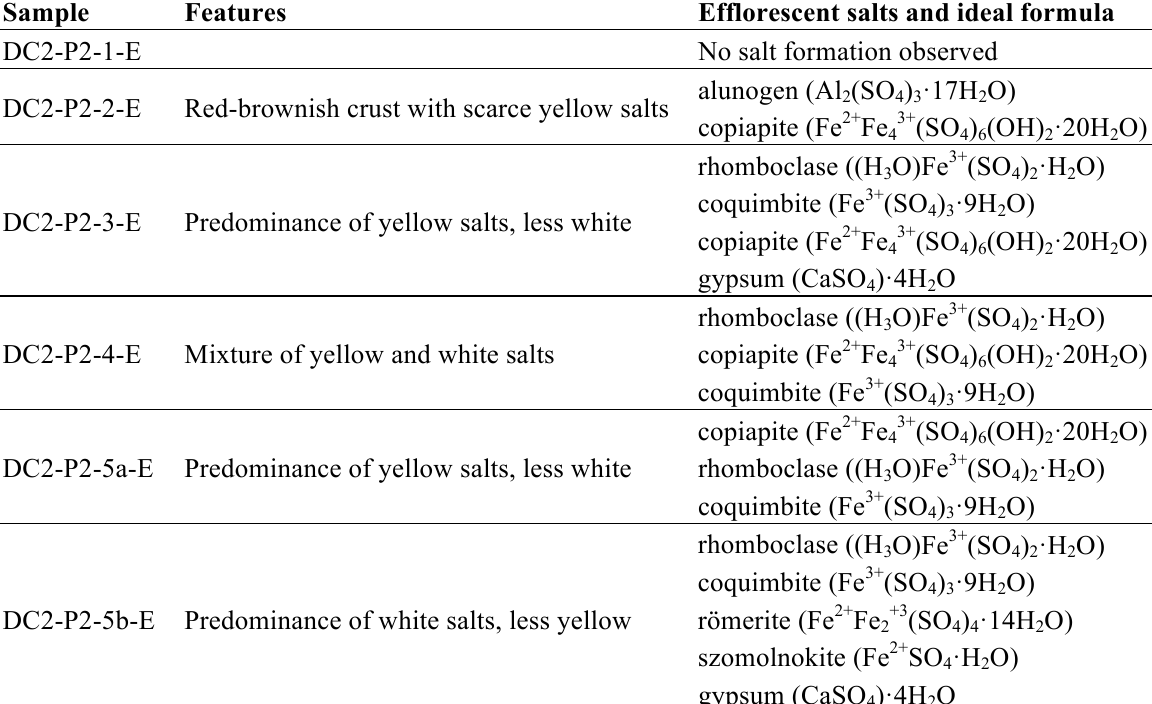
Table 3. Efflorescent salts that cover the tailings in DC2-P2